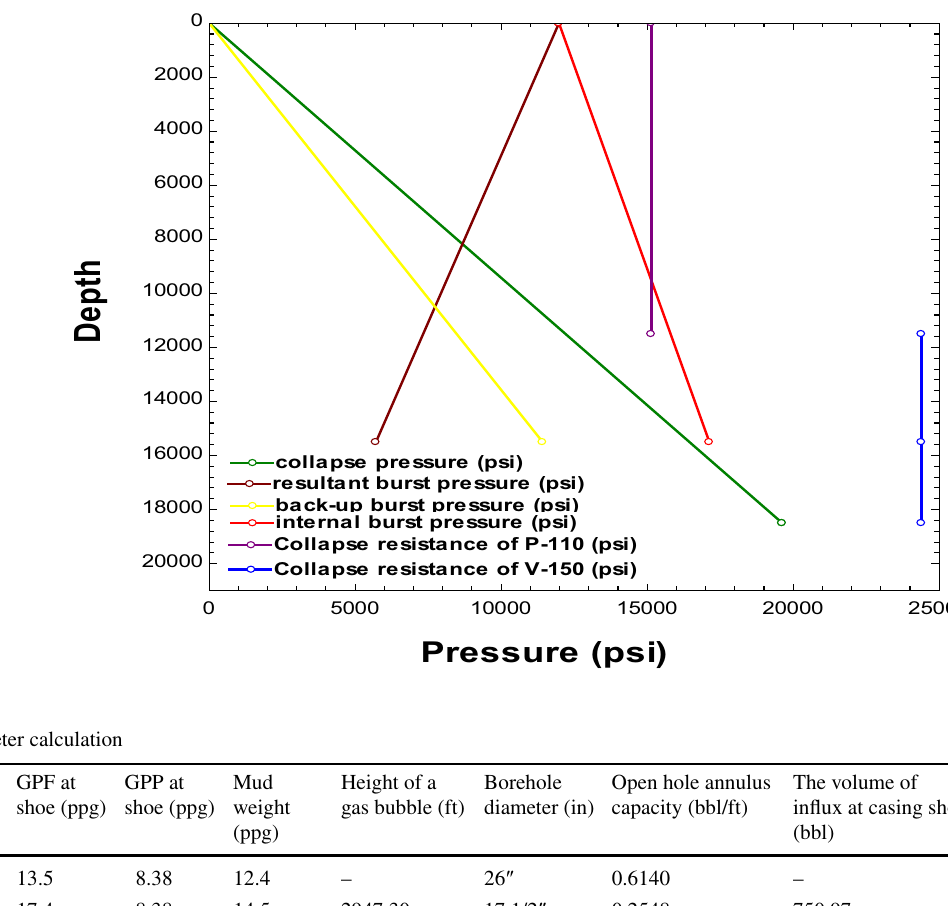
Fig. 14 Production casing selection